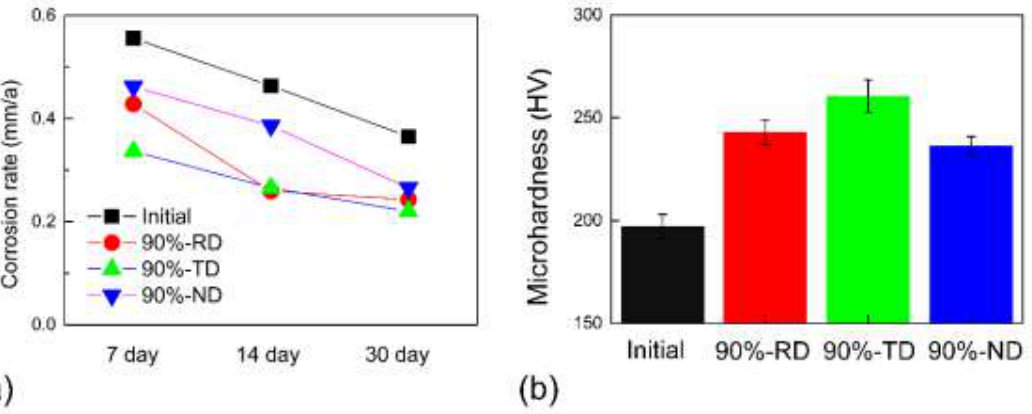
Figure 2. The corrosion rates of Ta-4%W in a 50 wt.% H 2 SO 4 solution containing 1 wt. % fluoride ions ( a ) and the micro-hardness of the corresponding test surfaces ( b ).